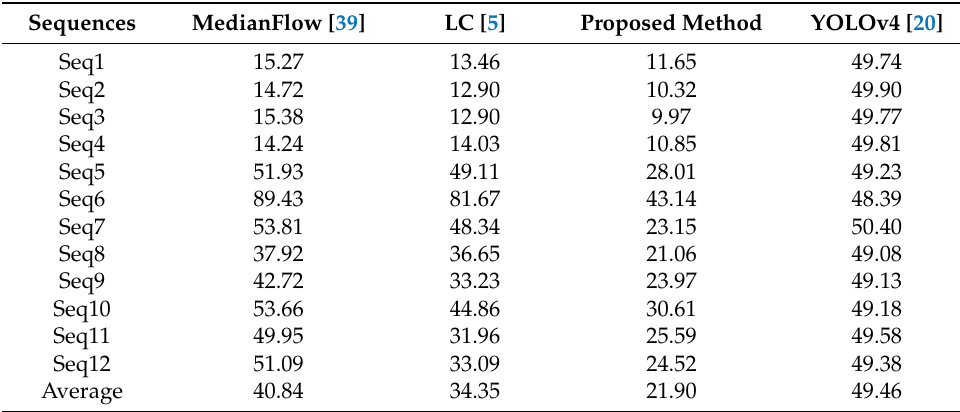
Figure 5. Frame-by-frame comparison of overlap score on Seq2. Yellow and purple shaded boxes indicate OV and OC, respectively. In the bottom, the red, light blue, and green boxes denote the proposed method (MedianFlow, YOLOv4), SiamRPN++ [30], and ground truth, respectively.